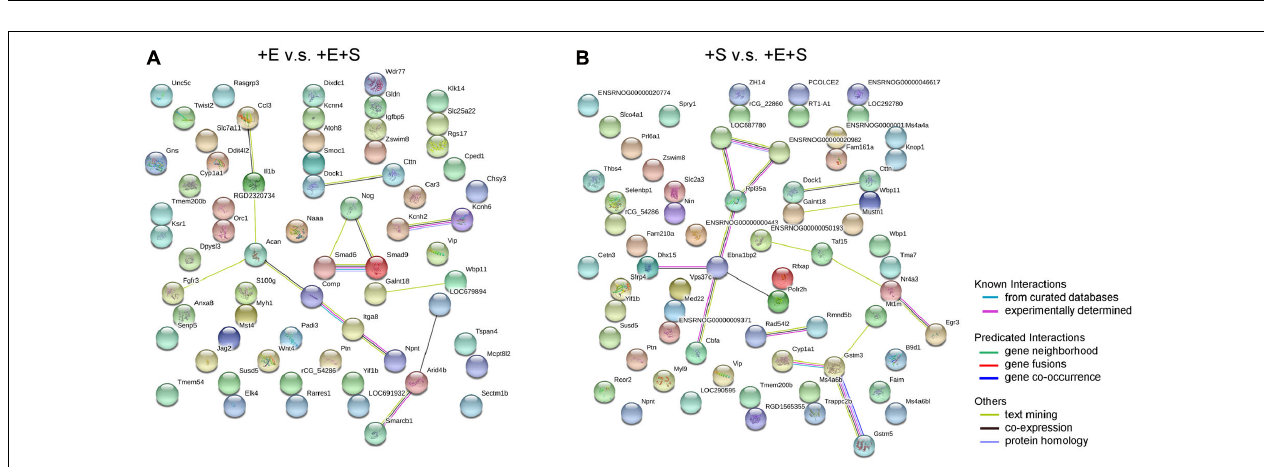
FIGURE 7 | Signaling pathway evaluation under different treatments. (A) Go term analysis between EF vs. co-stimulation and strain vs. co-stimulation. (B) KEGG pathway enrichment analysis of EF or strain vs. co-stimulation. Phosphorylation of ERK1/2 (Thr202/Tyr204) (C) and AKT1/2/3 (Thr308) (D) was detected by alpha screening assay. The alpha signal was normalized to that of BMSC ( n = 6, ** p < 0.01 compared with static control, ## p < 0.01, ANOVA).